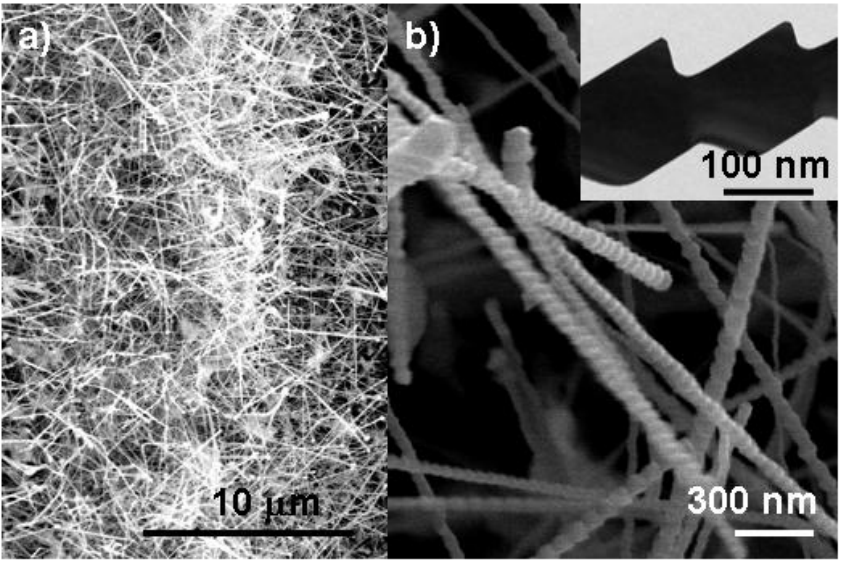
SnO nanowires. 2 4